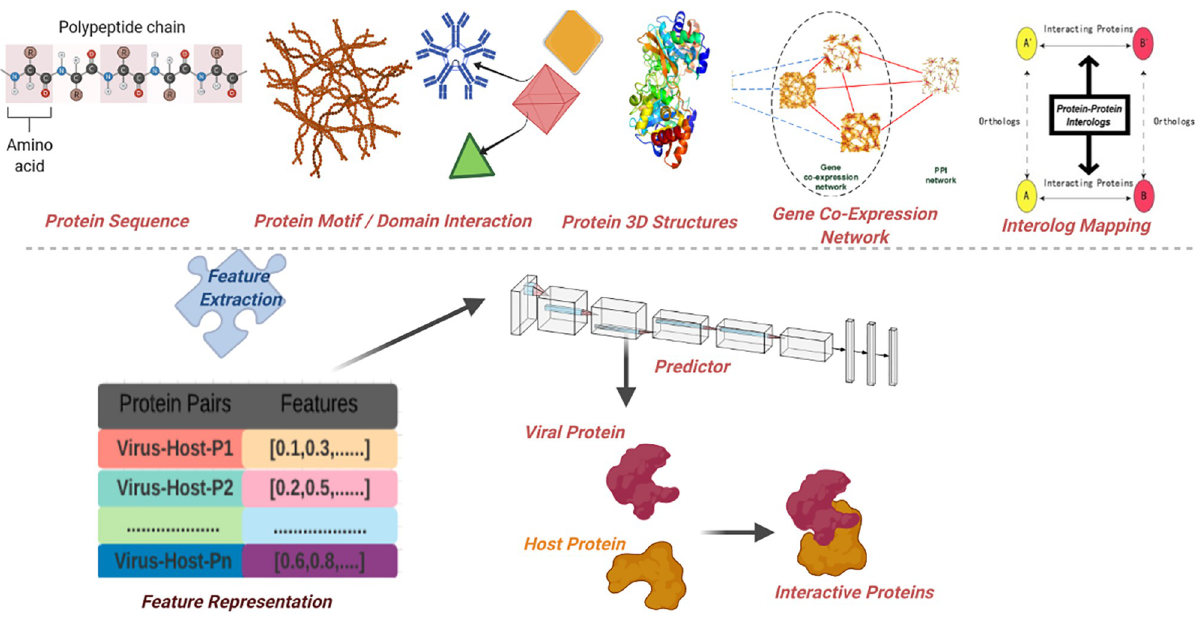
Fig 1. A generic categorization of different computational virus-host protein protein interaction predictors.